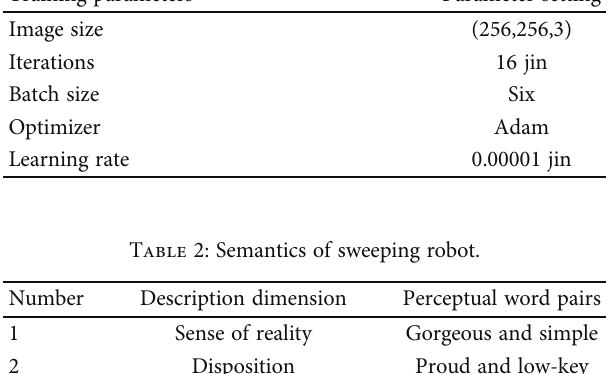
Figure 1: Mapping model construction process.